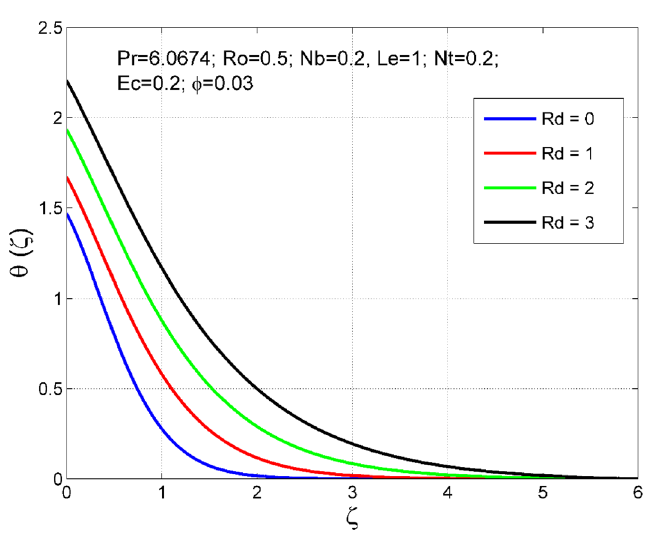
Figure 12. Effect of Rd on θ (ζ)